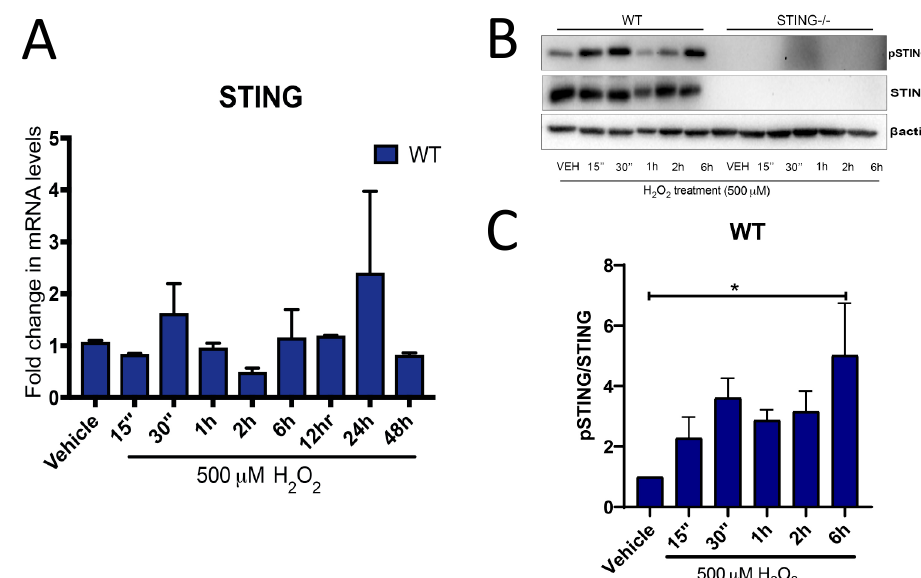
Figure 1. H 2 O 2 induces an upregulation in stimulator of interferon genes (STING) expression. Increased STING expression was detected by qPCR analysis ( A ) ( n = 4 for each time point) in WT MEF SV40 cells exposed to H 2 O 2 treatment as compared to vehicle control. Increased phosphorylation of STING (pSTING) was confirmed at the protein level by western blot analysis ( B ) with a lack of STING expression identified in STING − / − cells (representative blot of n = 5 blots). Quantification of pSTING expression relative to total STING in ( B ) is shown in ( C ). All data are expressed as mean ± SEM, * p < 0.05. Downstream of STING activation, pTBK1 (Figure 2A) and TBK1 (Figure 2B) protein expression was also determined by Western blot analysis, with increased pTBK1 expression identified in WT − / − cells at early time points (15 min–6 h) of H 2 O 2 treatment but not in the STING cells. A significant increase in pTBK1 levels was detected at 30 min (4.65 ± 1.43 fold; * p < 0.05) and 1 h (4.629 ± 1.33 fold; * p < 0.05) (Figure 2C) after H 2 O 2 treatment as compared to their genotype control group,